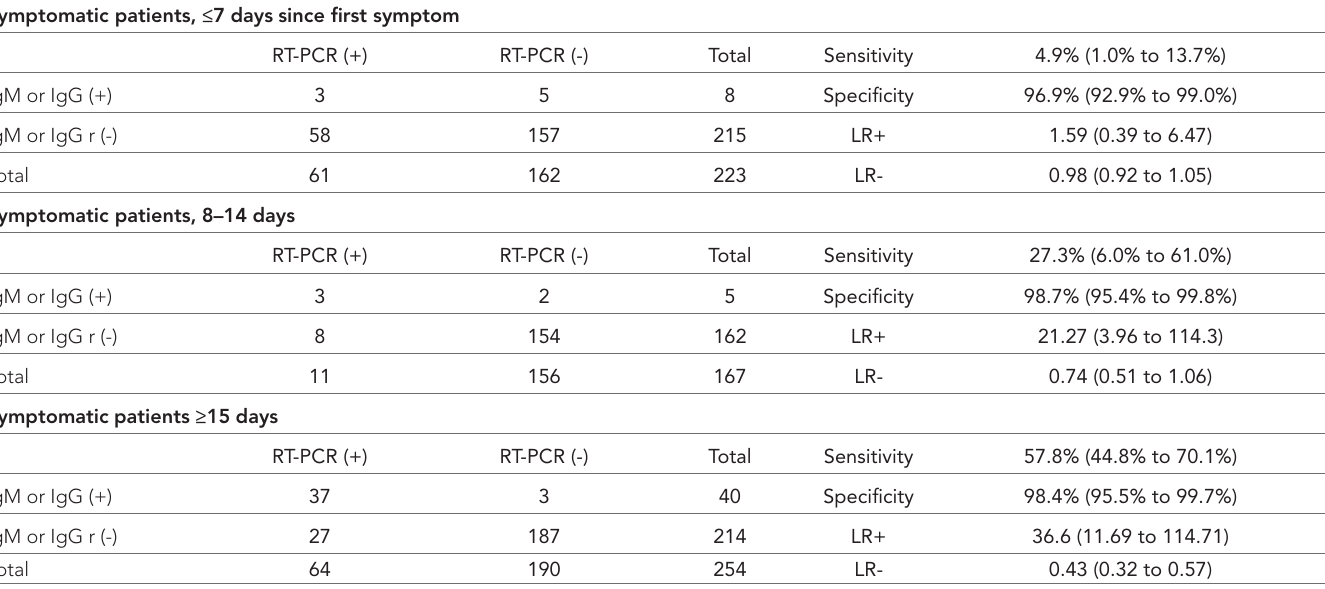
Table 2 Relative sensitivity, specificity, and likelihood ratios associated with serologic tests compared with RT- PCR test results in